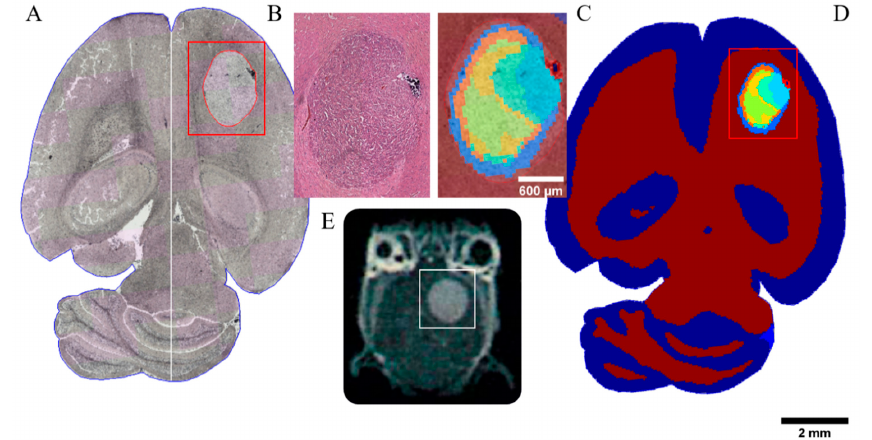
Figure 1. Multimodal analysis of the CTV in a representative untreated brain tumor section of a U87MG mCherry sample. ( A ) MALDI mass spectrometry image as technique for proteomics analy ‐ sis measured without staining. GTV is contoured in red within the evaluated region (red box). ( B ) H&E staining of tumor region. ( C ) The edges of the tumor are clearly shown by the segmentation of the protein/peptide detection and analysis determined by means of mass spectra. The resulting mass spectrometry data are consistent with the histologic annotation of the tumor. The clustering of the spectra shows a ring ‐ shaped separation. ( D ) Unsupervised clustering map of mass spectra. ( E ) Cor ‐ responding T1 ‐ weighted MR image highlighting the tumor area (white box). MALDI component analysis of five untreated and five low ‐ dose irradiated specimens (3 × 3 Gy) supported a peak of 1339 m / z as a potential marker for normal brain tissue, whereas the peak of 1562 m/z demarcated the tumors very well irrespective of treatment group. Figure 2 shows distinguished single mass spectra information in one exemplary U87MG_mCherry tumor and corresponding normal brain tissue measured in the same content area with both calculated areas at the same size. Using the Mascot database, a search for peak 1562 m / z identified the following human proteins: Negative regulator of P ‐ body association (NBDY_Human), X antigen family member 1 (XAGE1_Human), Translocase of inner mitochondrial membrane 8 homolog B (TIM8B_Human), Ubiquinol ‐ cytochrome c reductase complex III subunit VII (QCR8_Human). Comparison of un ‐ treated and irradiated tumors revealed differences regarding the tumor border. Figure 3 indicates, for example, an extension of the mass 1586.8 m / z beyond the tumor margins after irradiation within the irradiated area, whereas no expansion can be seen in untreated tumors. The same observations can be made by evaluating different mass peak intensities in one representative U87MG_mCherry section (Figure 4). Specific intensity maps of sin ‐ gle peaks (e.g., 852, 1459 and 1562 m / z ) simultaneously represent tumor area and possible invasive front of tumor cells spreading toward normal tissue.